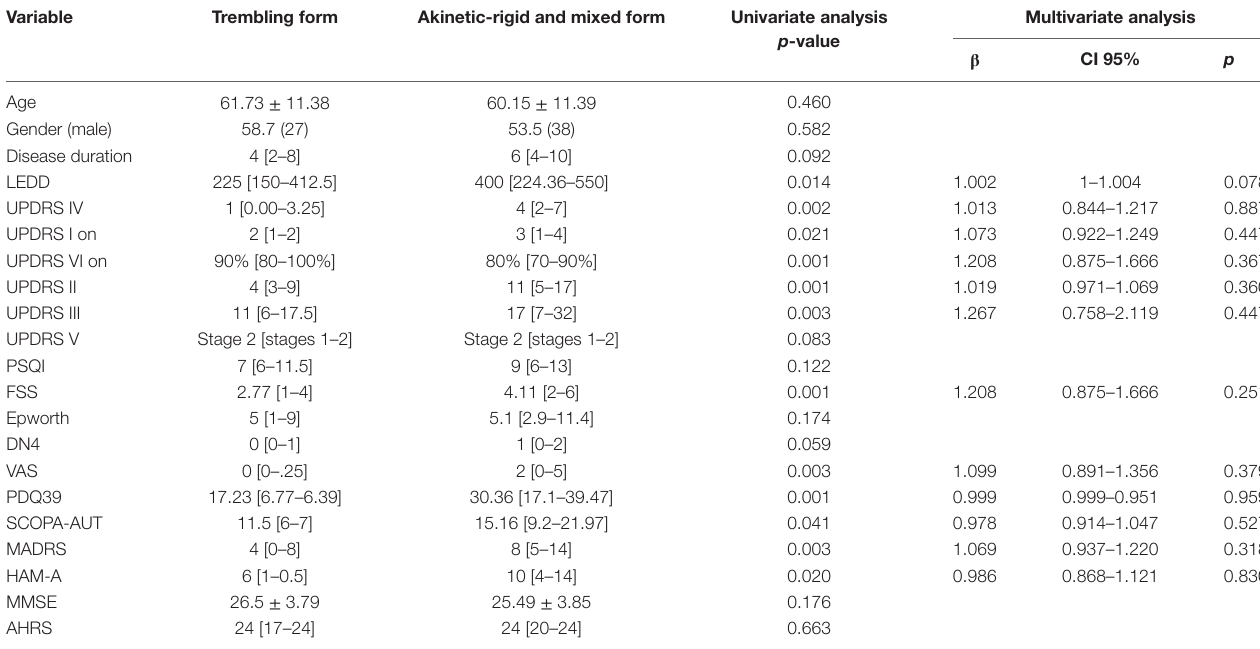
TaBle 3 | Comparison of non-motor signs between trembling form group and akinetic-rigid form and mixed form